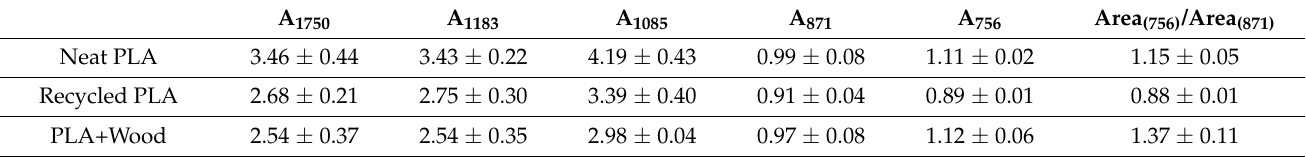
Table 1. Average absorbance values at specific wavelengths (1750 cm − 1 , 1183 cm − 1 , 1085 cm − 1 , 871 cm − 1 , 756 cm − 1 ) and ratio of the areas underlying the characteristic peaks at 871 and 756 cm − 1 . A 1750 A